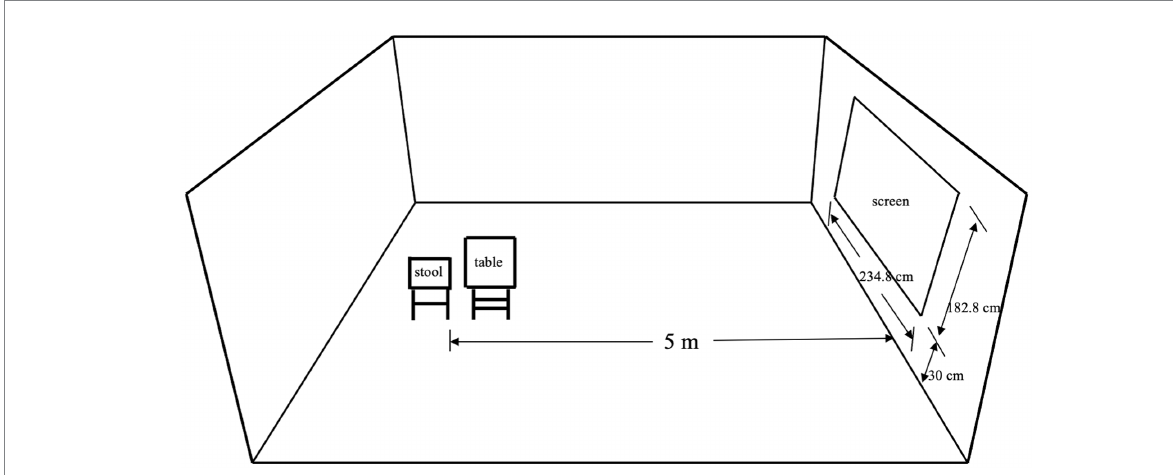
FIGURE 1 A schematic diagram of the lab.